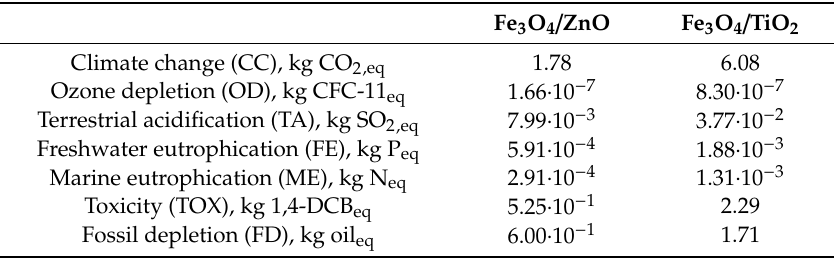
Table 2. Life Cycle Impact Assessment results for di ff erent